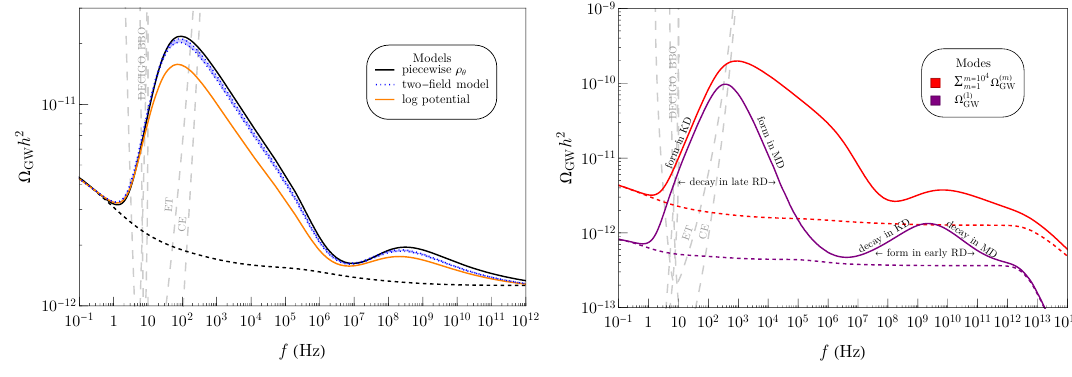
Figure 12 . Left: an illustration of the model dependence in the stochastic string gravitational wave spectrum. The solid black line is the case where the rotation energy density ρ θ follows a piecewise scaling T 7 T MK as shown in figure 1. The colored curves are for the two-field model (blue) and the logarithmic potential (orange) with evolution demonstrated in figure 1. For the two-field model, we show the blue dotted curves for different ratios of the soft masses of the two /m P = 1 , 100 . The dashed black curve shows the standard string spectrum in a fields ¯ P and P , m ¯ P Λ CDM cosmology. We fix ( T KR , T RM ) = (1 GeV , 100 GeV) . Right: an illustration of the difference between the m = 1 amplitude (purple) and the total amplitude summed over 10 4 harmonics (red). The sum over high modes partially flattens the right side of the kination induced peak, shifting the spectral dependence from f − 1 to f − 1 / 3 . We fix ( T KR , T RM ) = (1 GeV , 10 TeV) . In both panels, the second, smaller triangle at high frequencies is an additional fingerprint of axion kination and arises from loops that form in the early radiation dominated era and decay in the subsequent matter or kination dominated eras (see table 1). Both panels assume Gµ = 5 × 10 − 15 , and α = 0 . 1 . The drop in the spectrum above f ∼ 10 12 Hz arises from only considering loops that form after the string network reaches scaling, t k > t scl . We take scaling to be reached shortly after string formation, √ t k ∼ 1 /H ( T = µ ) . However, string friction with the thermal bath can delay scaling and shift this high frequency cutoff to lower frequencies [14, 152, 158, 159]. We do not include this model dependent effect in this